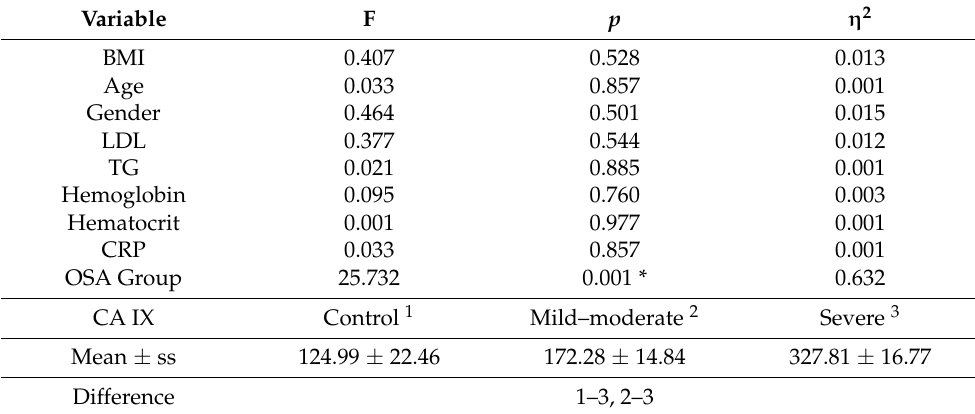
Table 3. Effect of CA-IX on OSA groups when the effect of variables is